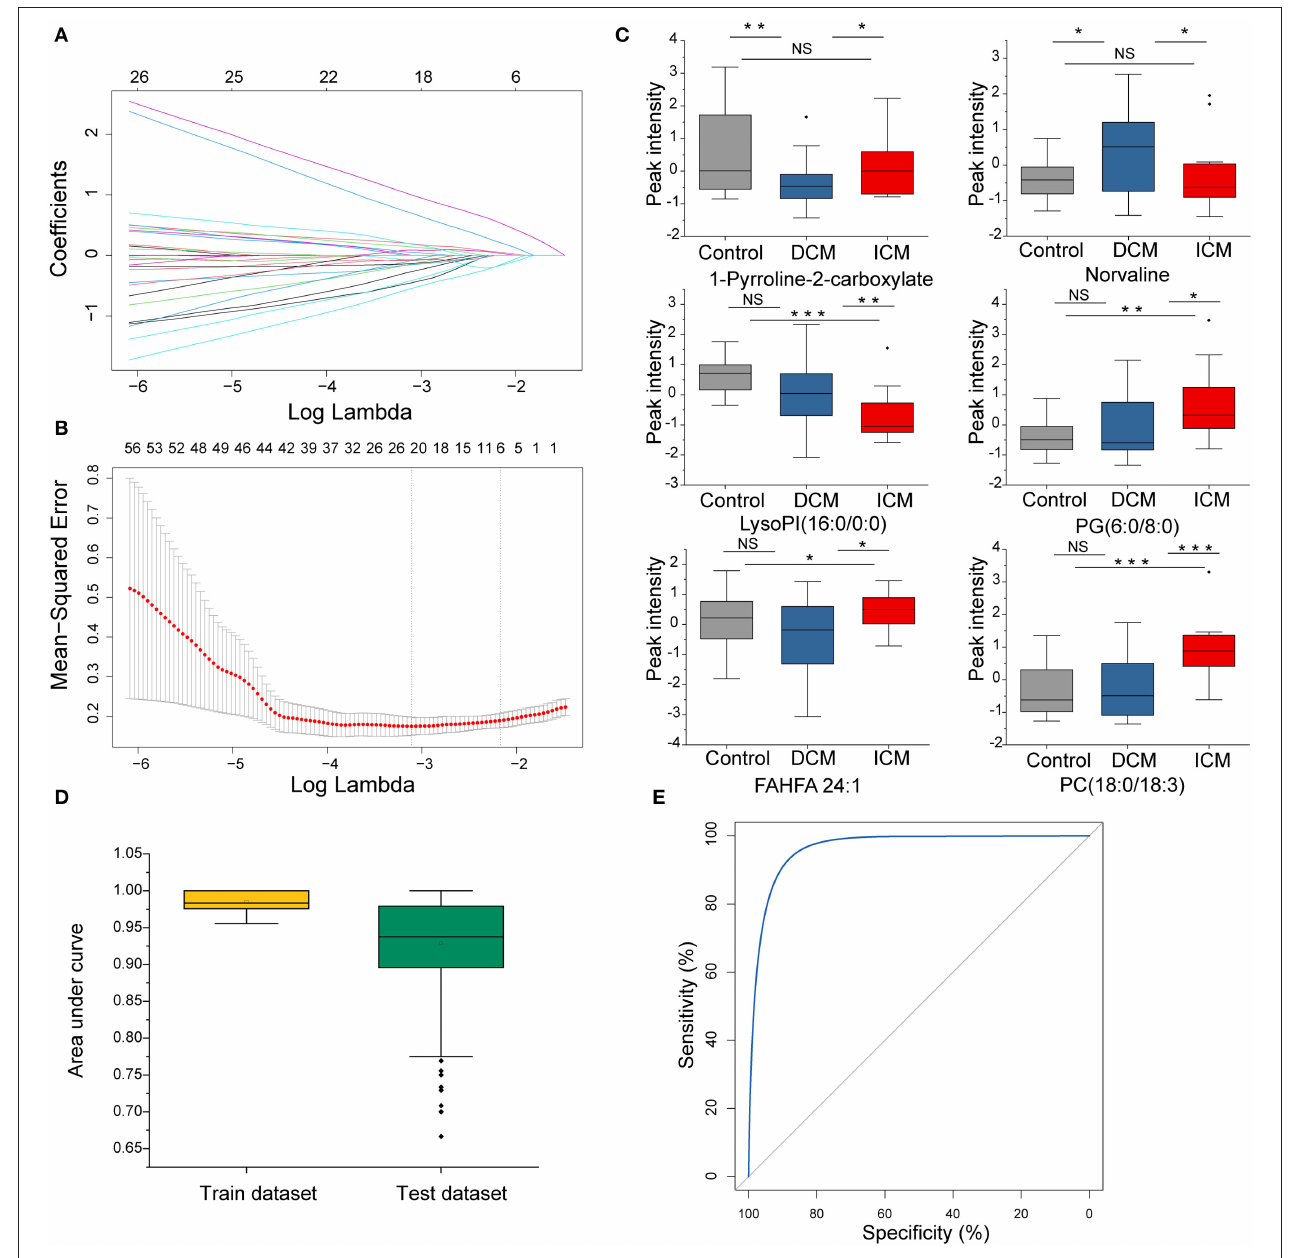
FIGURE 5 | The disease specific dysregulated metabolites distinguish patients with DCM from patients with ICM. (A) LASSO coefficient profiles of the disease-specific features. A coefficient profile plot was produced against the log( λ ) sequence. Dotted vertical line was drawn at the optimal λ at minimum criteria and 1 standard error (1-SE criteria). The model at 1-SE criteria was selected as the final model with 6 non-zero coefficients. (B) Tuning parameter ( λ ) selection in the LASSO model used 10-fold cross-validation via minimum criteria. The binomial deviance was plotted vs. log ( λ ). (C) Bar plot of the 6 metabolites in DCM and ICM and HC. Student’s t -test for two group comparison. (D) Plot of the area under curve for the created biomarker model in training and testing dataset by cross validation under 500 random replications. Data are presented as mean ± SD in bar plots. (E) The ROC created by a combination of six selected features based on whole dataset. * P < 0.05, ** P < 0.01, *** P <